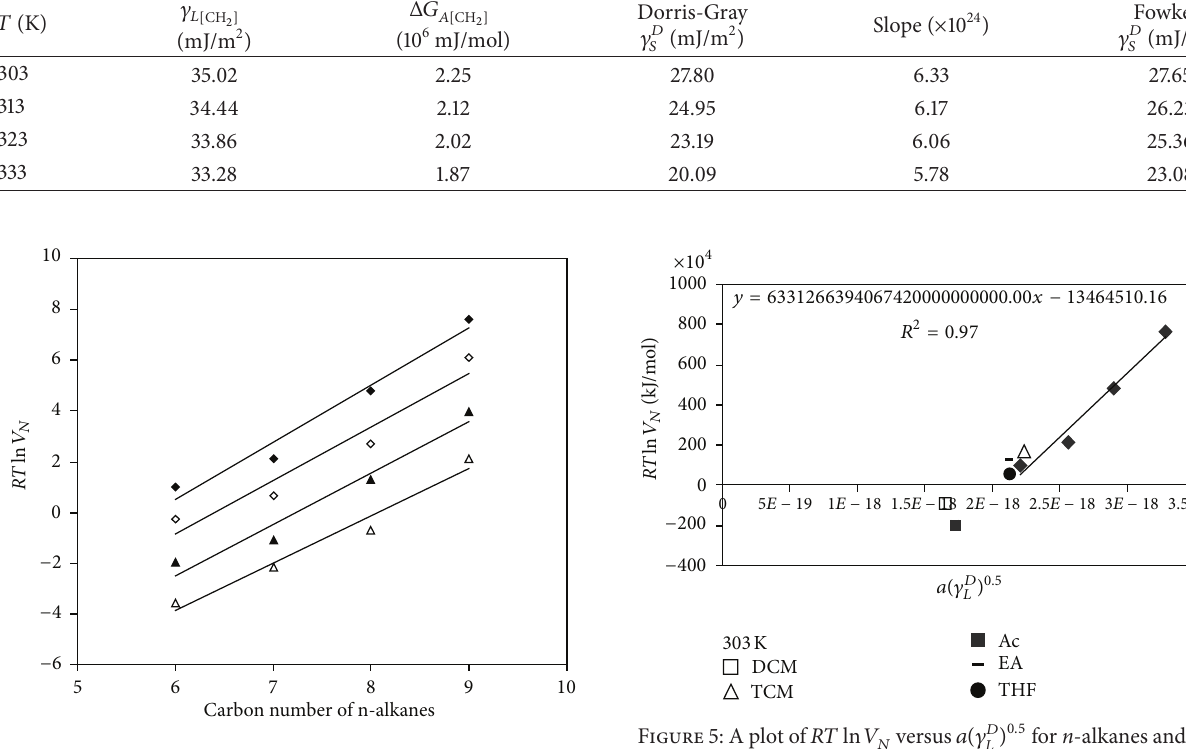
Table 1: The adsorption energy of a methylene group, Δ𝐺 𝐴[ and dispersion component of surface free energy, 𝛾 𝐷 𝑆 , values calculated by the Dorris-Gray and the Fowkes approaches for 𝐿 determined at studied temperatures.